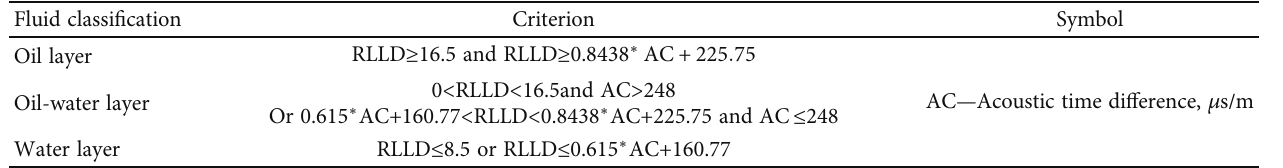
Table 7: Discrimination standard